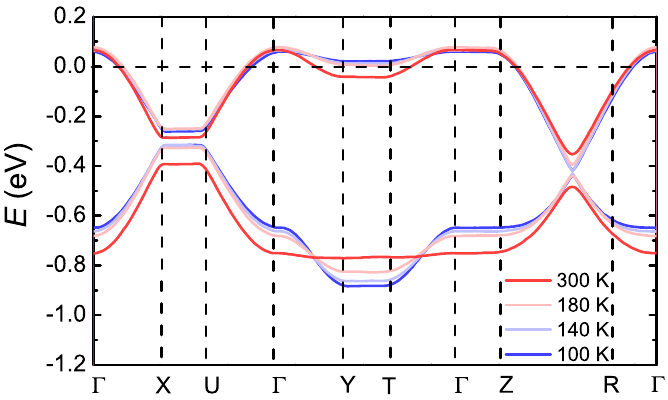
Figure A2. Band structure of (TMTTF) 2 SbF 6 in a temperature range from 300 K (dark red) to 100 K (dark blue) on the selected k -path: Γ ( 0,0,0 ) → X ( 0.5,0,0 ) → U ( 0.5,0.5,0 ) → Γ ( 0,0,0 ) → Y ( 0,0.5,0 ) → T ( 0,0.5,0.5 ) → Γ ( 0,0,0 ) → Z ( 0,0,0.5 ) → R ( 0.5,0.5,0.5 ) → Γ ( 0,0,0 )